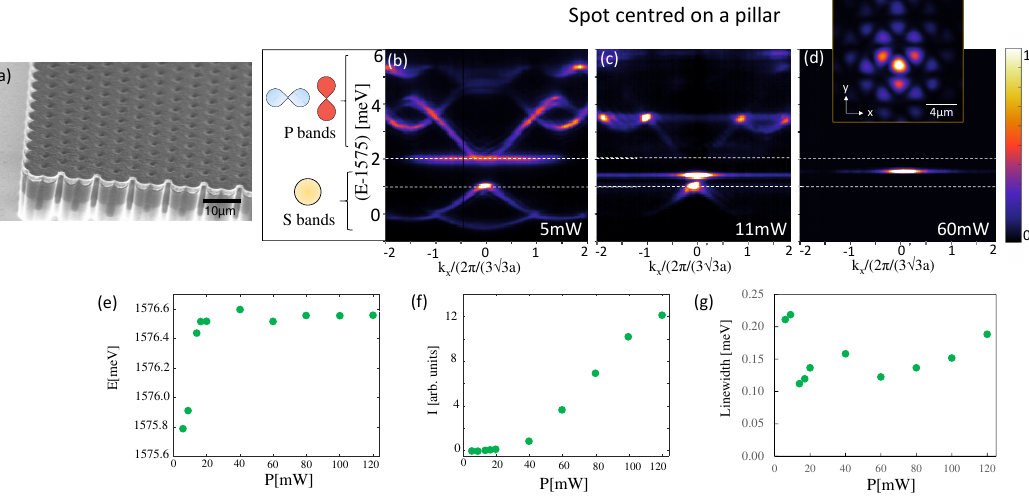
Figure 1: (a) Scanning electron microscope image of the polariton honeycomb lat- tice under study. (b) Energy and in-plane momentum resolved emission from the centre of the lattice under low excitation power (5 mW). The emission is recorded = 0.87 µ m − 1 , for an excitation spot centred on a single pillar. The low power for k y emission is virtually identical for a spot centred in a hole of the lattice. Dashed lines show the lower and upper limits of the gap between s- and p-bands. (c)-(d) Emis- sion at 11 mW and 60 mW, showing the emergence of a localised gap state. The inset in (d) shows the real space emission of the gap state at 60 mW. (e)-(f) Energy and emission intensity of the gap state measured as a function of excitation power. (g) Measured linewidth (full width at half maximum) of the gap state extracted from a Gaussian fit to its spectral